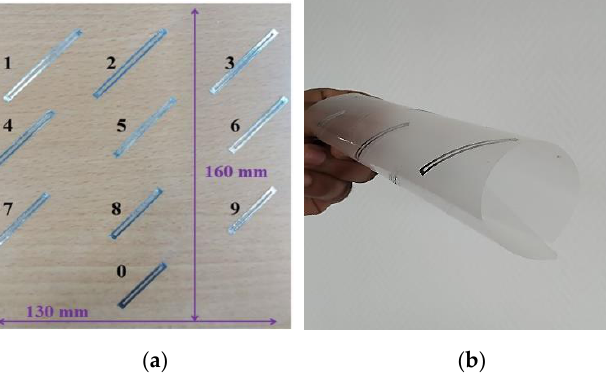
Figure 10. Proposed label: ( a ) Fabricated Chipless tag; ( b ) Image of fabricated tag in rolled form.